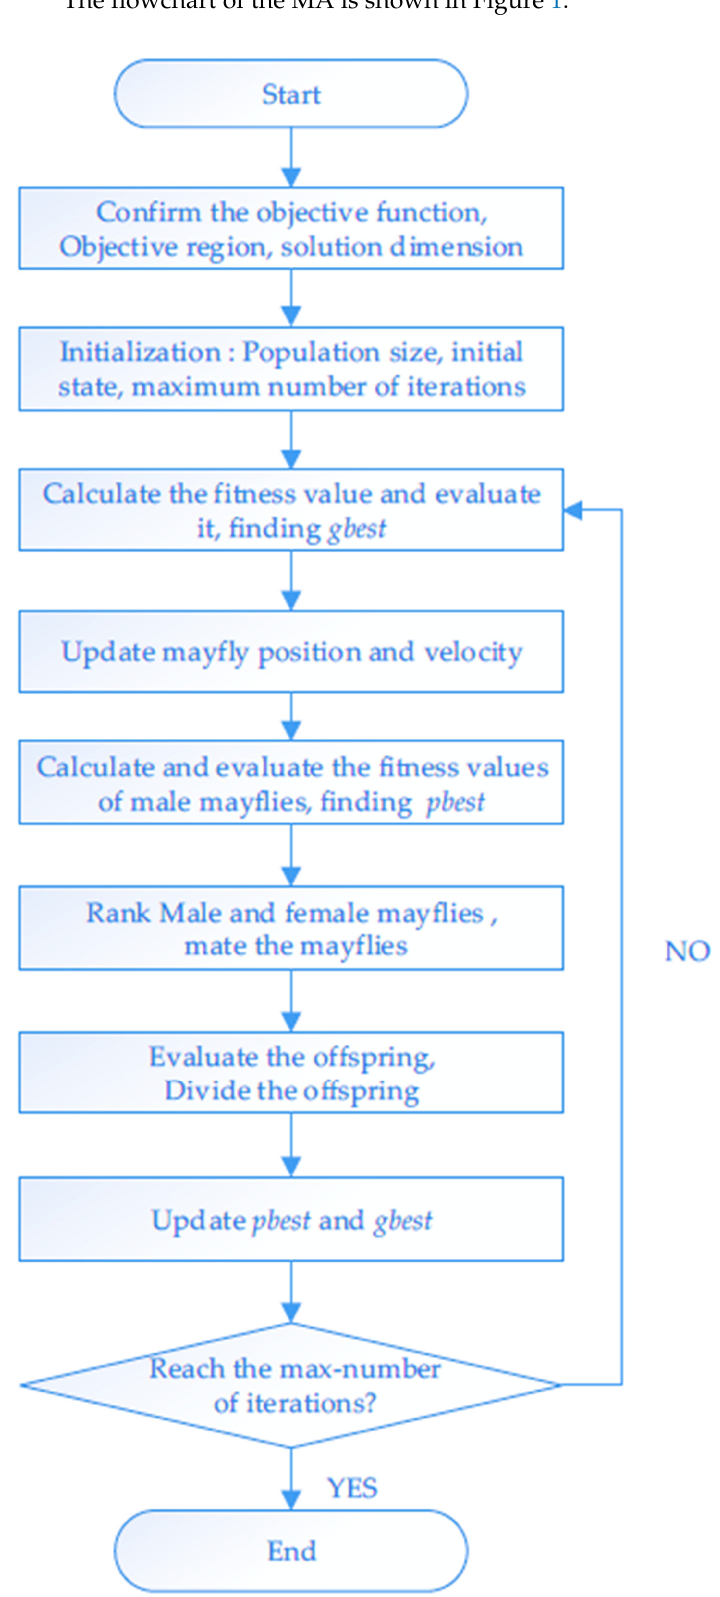
Figure 1. Flowchart of the Mayfly